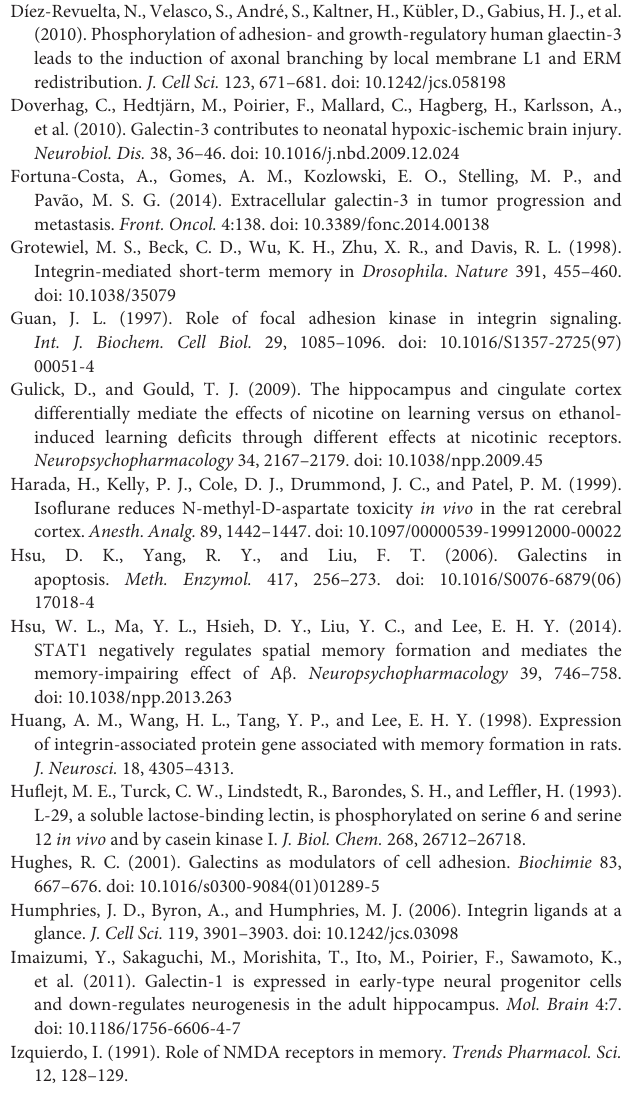
FIGURE S3 | Locomotor activity measures are similar in WT and galectin-3 KO mice. The WT and galectin-3 KO mice were subjected to locomotor activity measures in an activity chamber and the (A) Number of crossovers ( t ( 1,10 ) = 0.07, P > 0.05), (B) Total distance moved ( t ( 1,10 ) = 0.06, P > 0.05), (C) Distance moved in the center region ( t ( 1,10 ) = 1.24, P > 0.05) and (D) Mean speed of movement ( t ( 1,10 ) = 0.6, P > 0.05) were recorded. N = 6 each group. Data are mean ± SEM. FIGURE S4 | Contextual fear conditioning training and NMDA decrease galectin-1 expression in the rat hippocampus. (A) Western blot showing galectin-1 expression and quantitative analysis of galectin-1 expression in the CA1 area of trained and non-trained rats ( t ( 1,10 ) = 76.74, P < 0.001). N = 6 each group. (B) Western blot and quantitative analysis showing the effect of NMDA injection (12.5 mM) on galectin-1 expression in rat CA1 area ( t ( 1,10 ) = 13.54, P < 0.001). N = 6 each group. (C) Effect of galectin-1 siRNA transfection on contextual fear memory in rats ( t ( 1,13 ) = 2.3, P < 0.05). N = 7 or 8. (D) Western blotting showing galectin-1 expression in control siRNA and galectin-1 siRNA-transfected animals. The quantified result is also shown ( t ( 1,13 ) = 26.43, P < 0.001). Gal-1: galectin-1. Data are mean ± SEM. ∗ P < 0.05, # P <